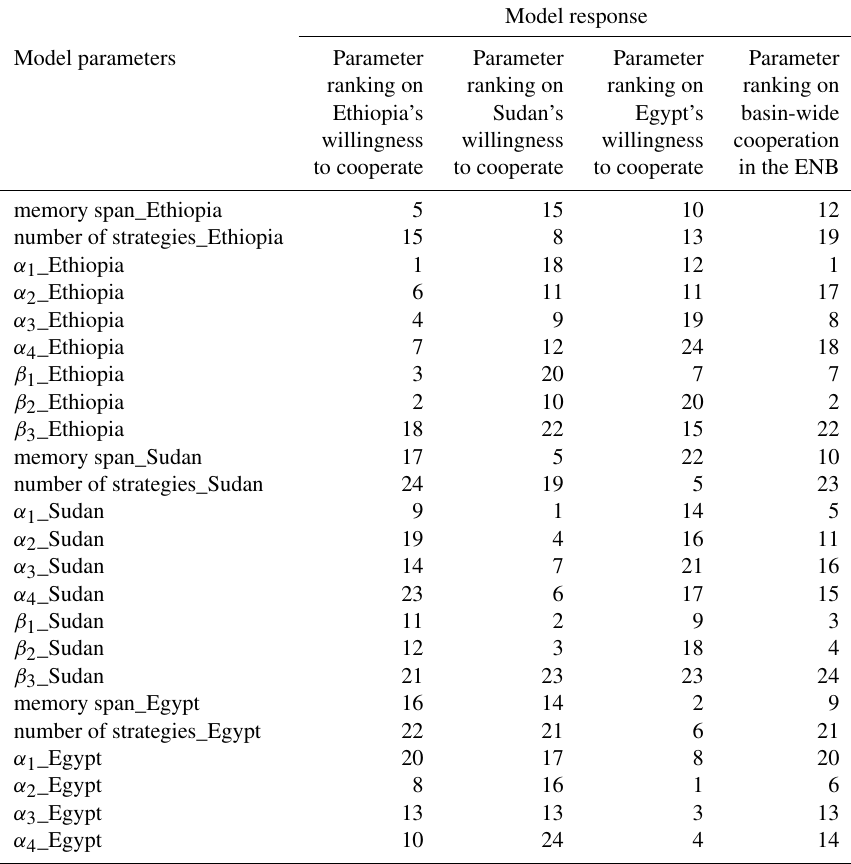
Table 3. Parameter rankings based on the sensitivity analysis. Parameters with low values are those to which the model response is most